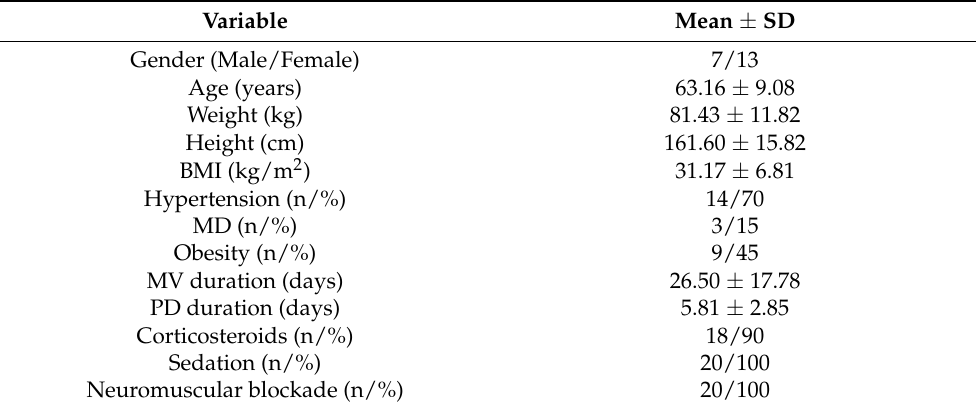
Table 1. Anthropometric characteristics and morbid history of patients with shoulder pain, n = 20.